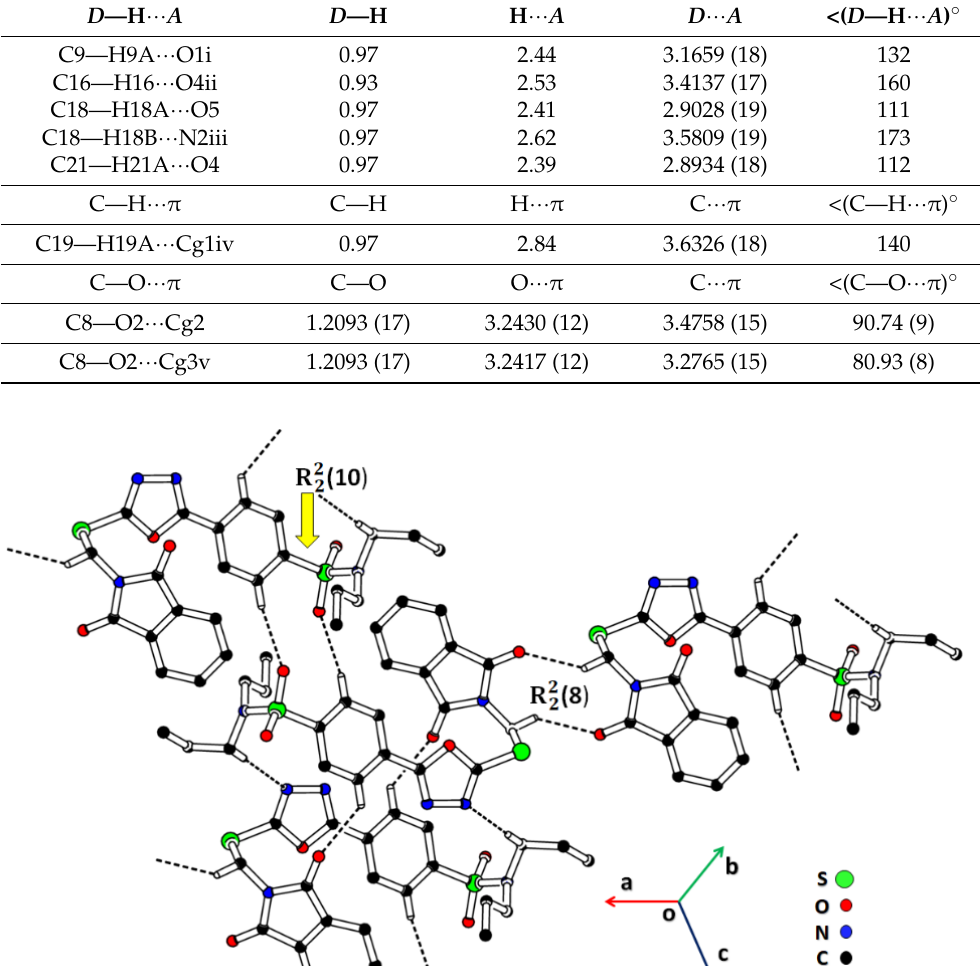
Table 2. Geometry of hydrogen bond (bond length in Å and angle in ◦ ) for PESMP .